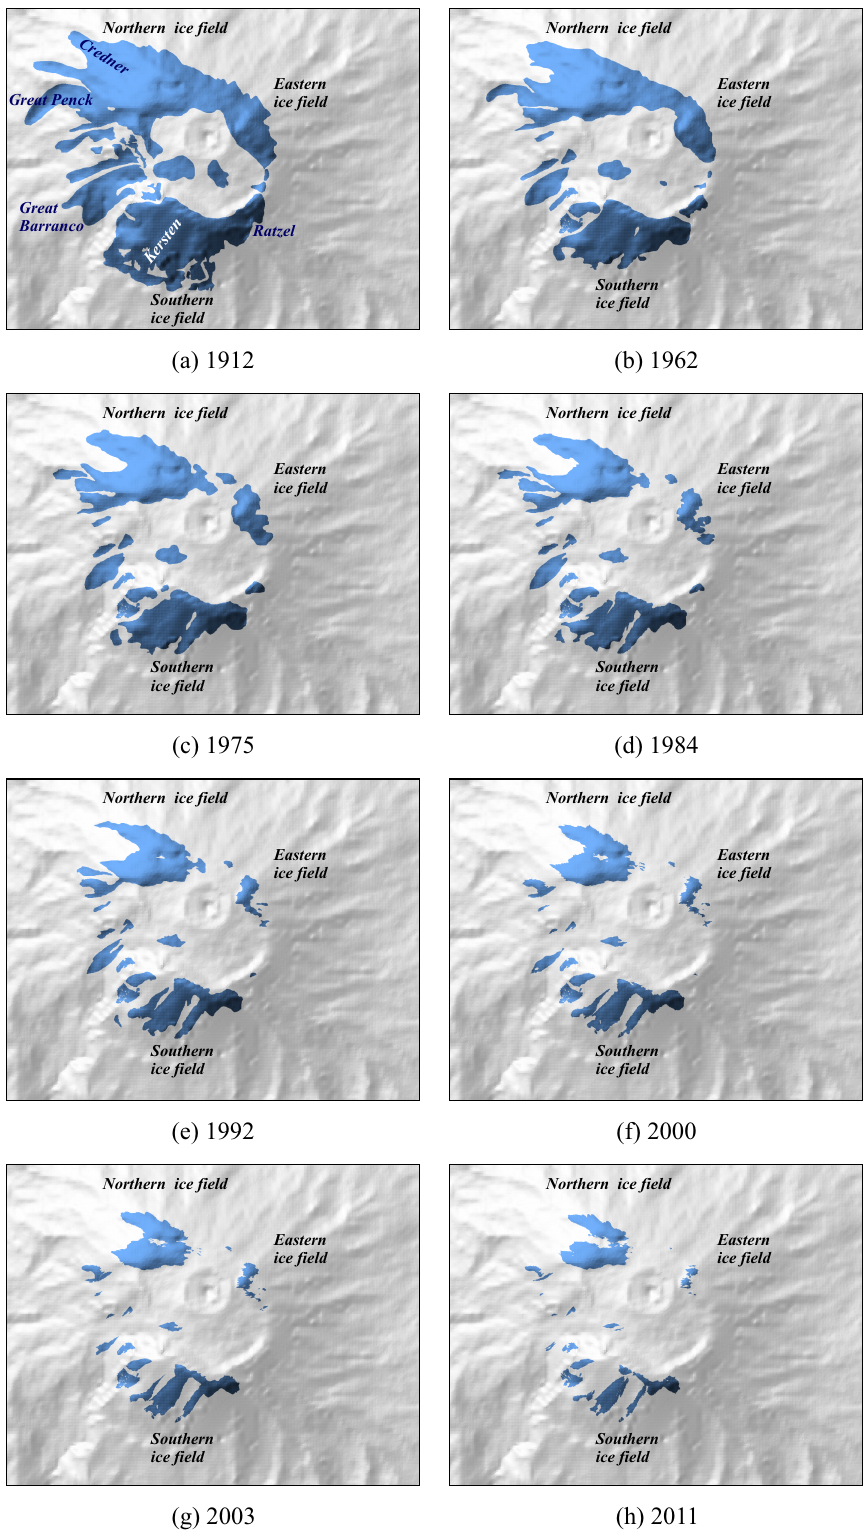
Fig. 2. Ice retreat over Kilimanjaro based on the revised areal extent for the following years: (a) 1912, (b) 1962, (c) 1975, (d) 1984, (e) 1992, (f) 2000, (g) 2003, and (h) 2011. An interactive 3-D illustration of the sequence can be sourced in the Supplement.